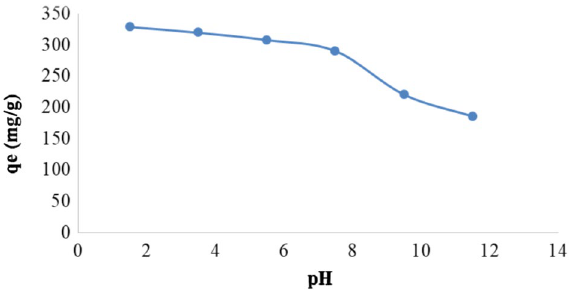
Figure 5. The pH solution impact on the of KMnO 4 adsorption by Ox-FVESP